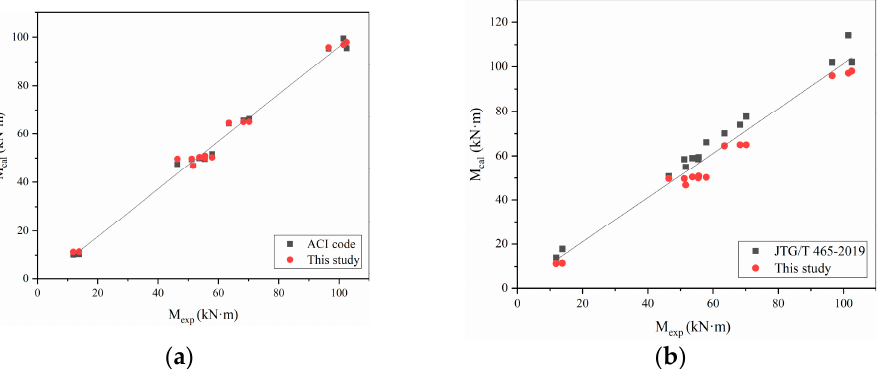
Figure 14. Comparisons between experimental results ( M exp ) and predicted values ( M cal ). ( a ) M exp versus M cal of this study and ACI code, ( b ) M exp versus M cal of this study and JTG/T 465-2019.